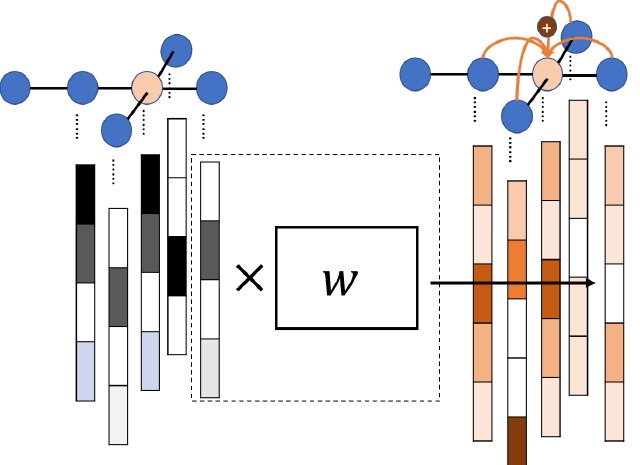
Figure 1. Graph convolutional neural network. Node features are updated with weights w (node features after arrows in the figure). Then, the node of interest (orange) is updated with the features of its